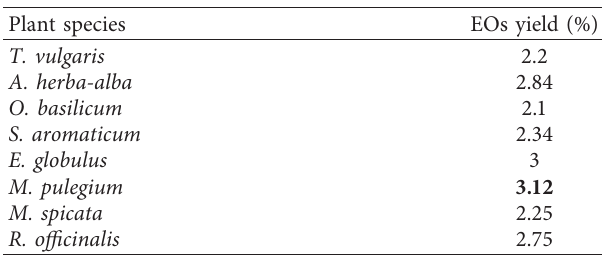
Table 2: The essential oil yields.